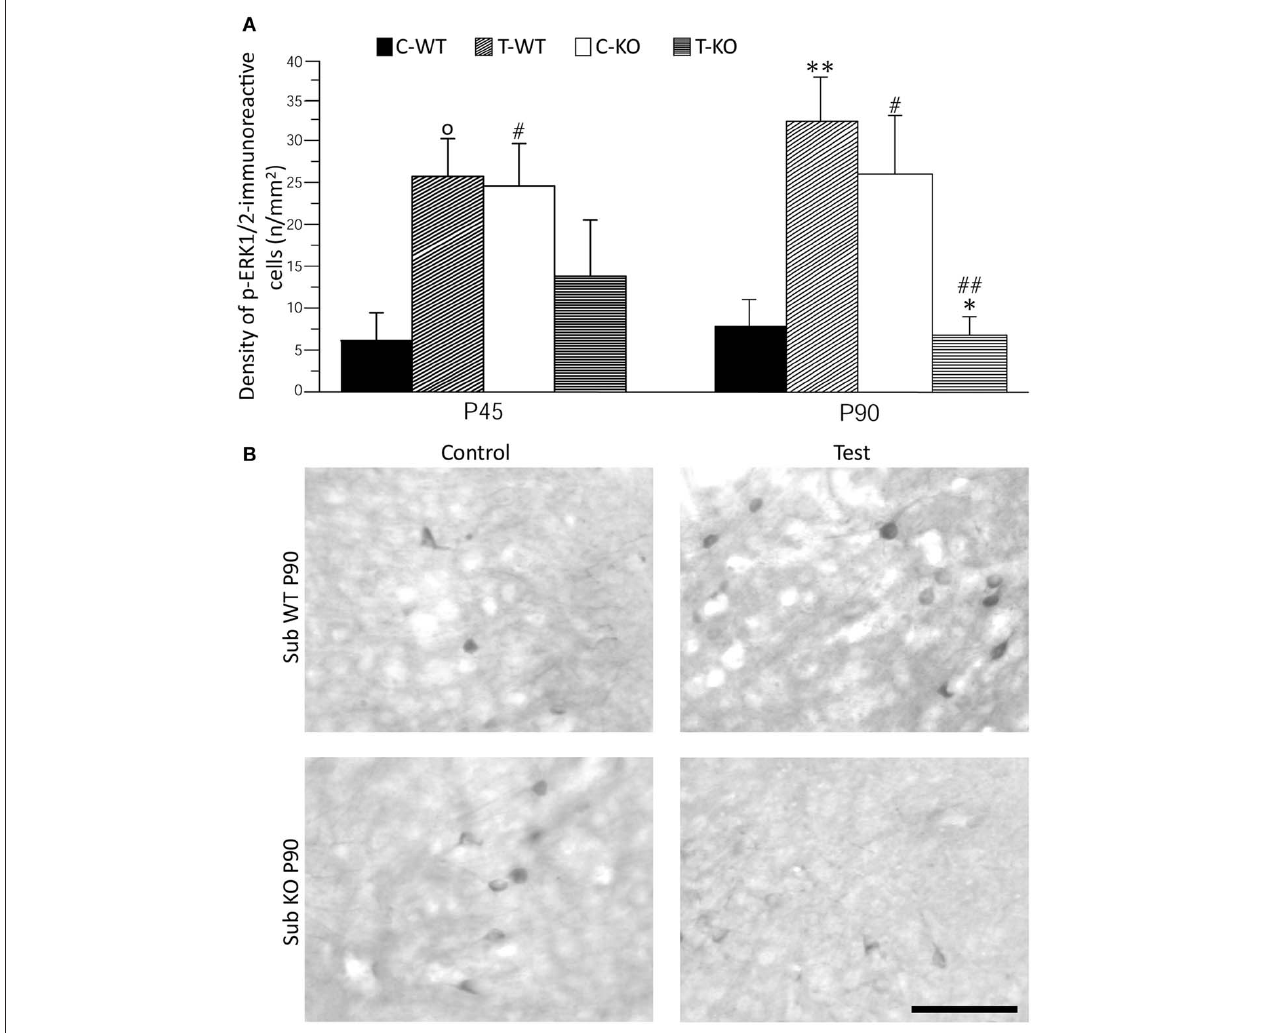
100 μ m. C-WT, WT mice not exposed to auditory stimulus; T-WT, WT mice exposed to the audiogenic test; C-KO, Fmr1 KO mice not exposed to auditory stimulus; T-KO, Fmr1 KO mice tested. O 0.1 < P < 0.05, ∗ P < 0 . 05, ∗∗ P < 0 . 01, acoustically stimulated group vs. the respective unstimulated group; # P < 0 . 05, ## P < 0 . 01, Fmr1 KO vs. WT mice with similar treatment (tested or not tested). Three-way ANOVA followed by LSD